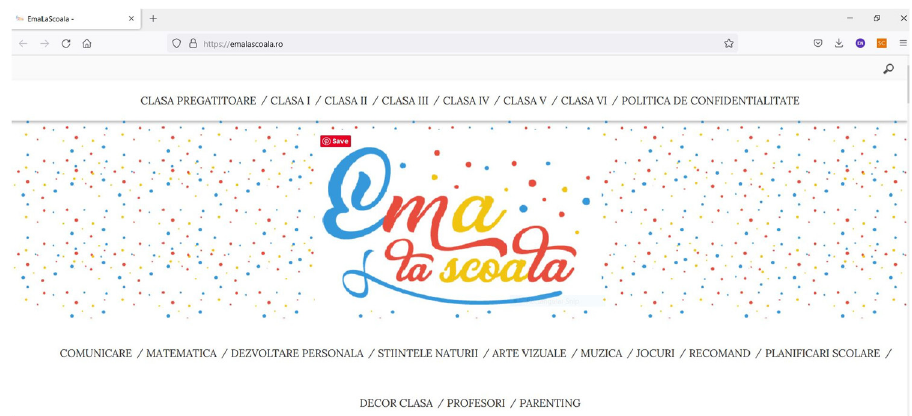
Figure 4: Ema la ș coal ă [ Ema at school ]